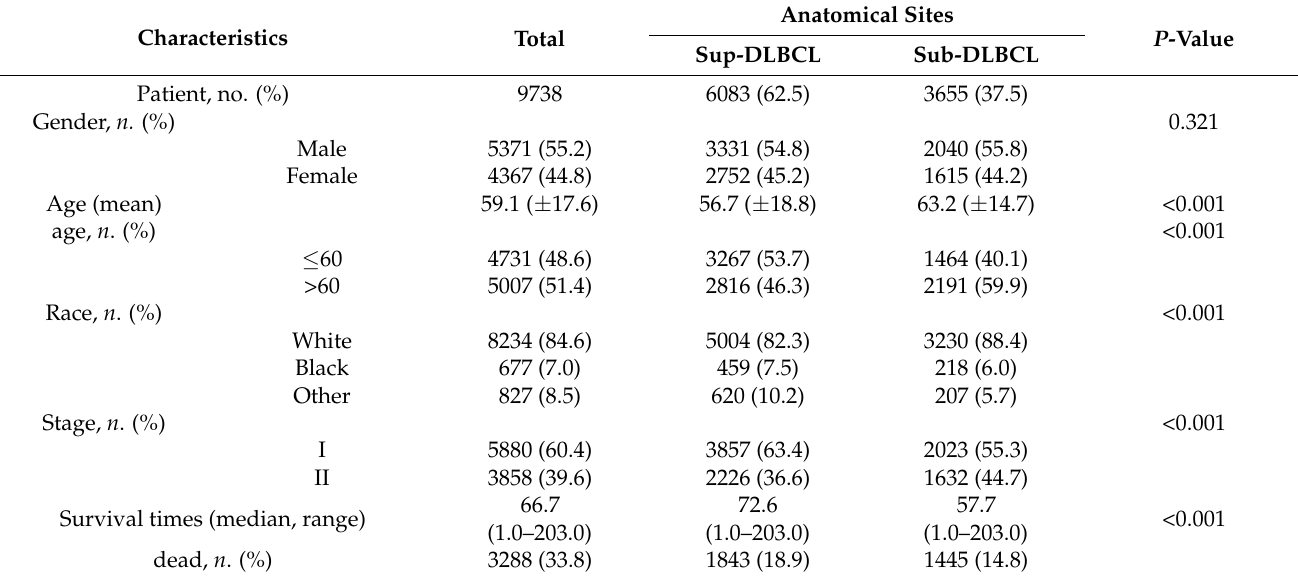
Table 1. Demographic characteristics of patients with early-stage nodal diffuse large B-cell lymphoma.